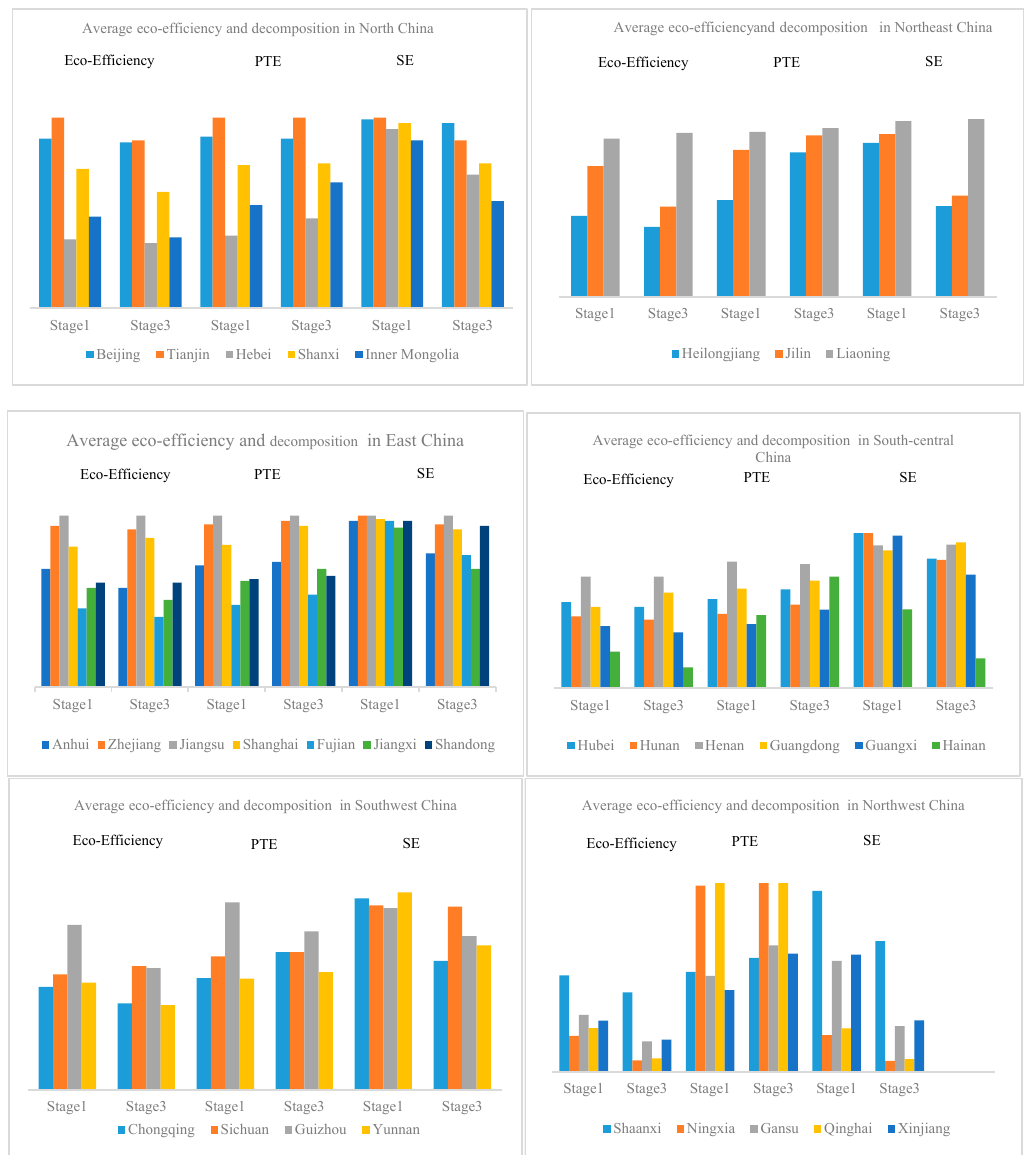
Figure 5. The average eco-efficiency and its decomposition of China’s tourism industry.